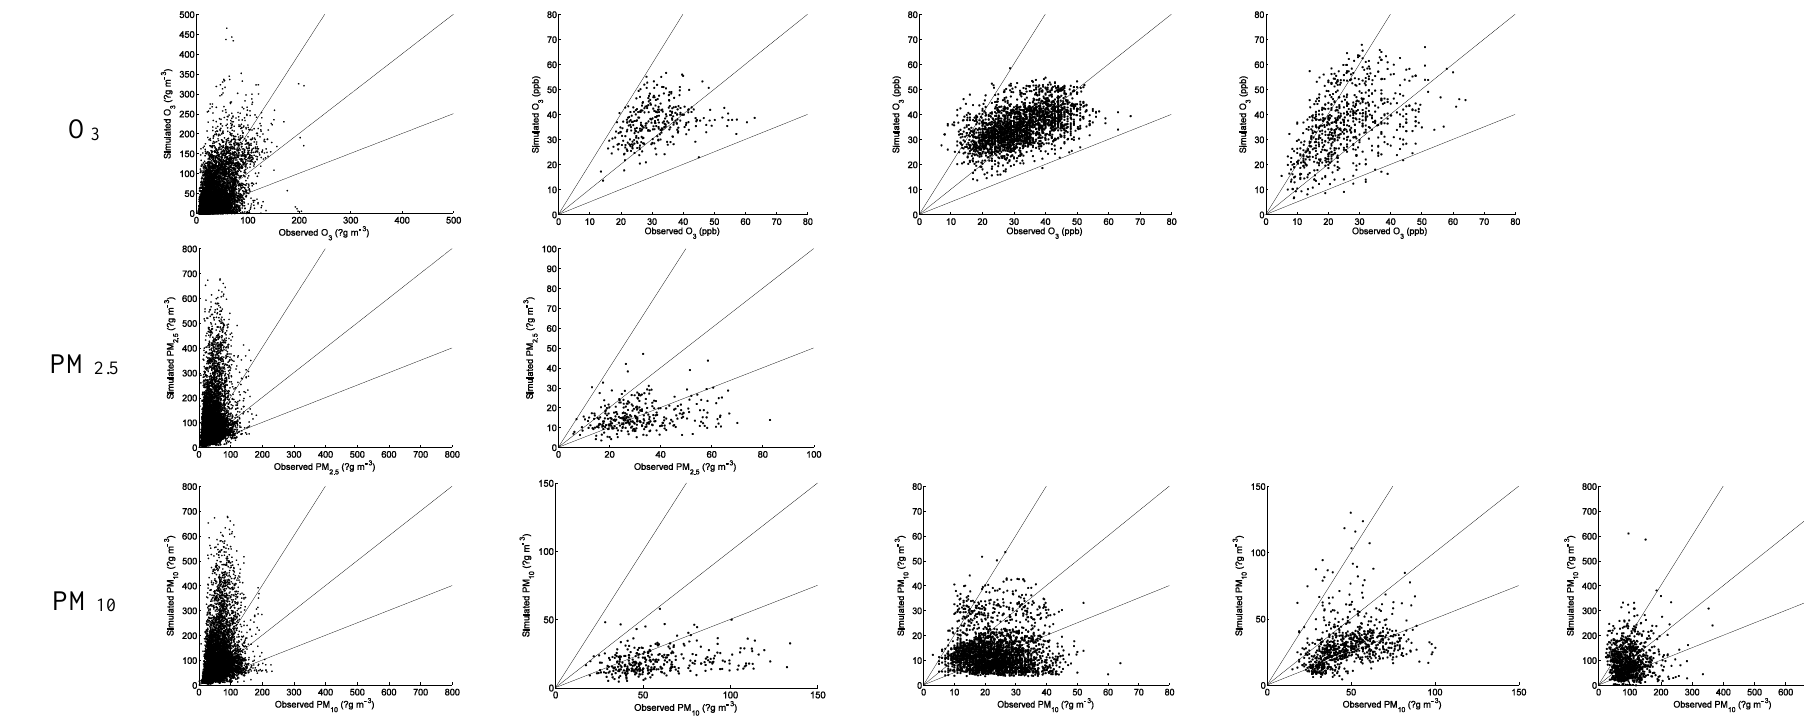
Figure 5. Simulated and observed surface mixing ratios of CO, NO, NO 2 , SO 2 , and mass concentrations of PM 2.5 and PM 10 for the 2006 simulation with